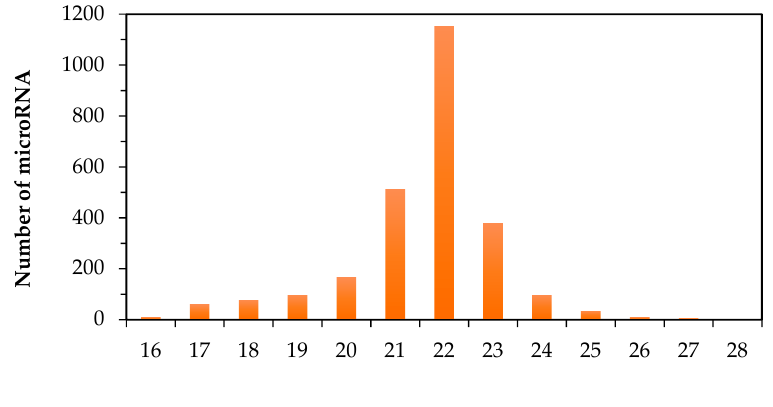
Figure 1. Distribution of human mature microRNA as a function on the number of nucleotides per microRNA.